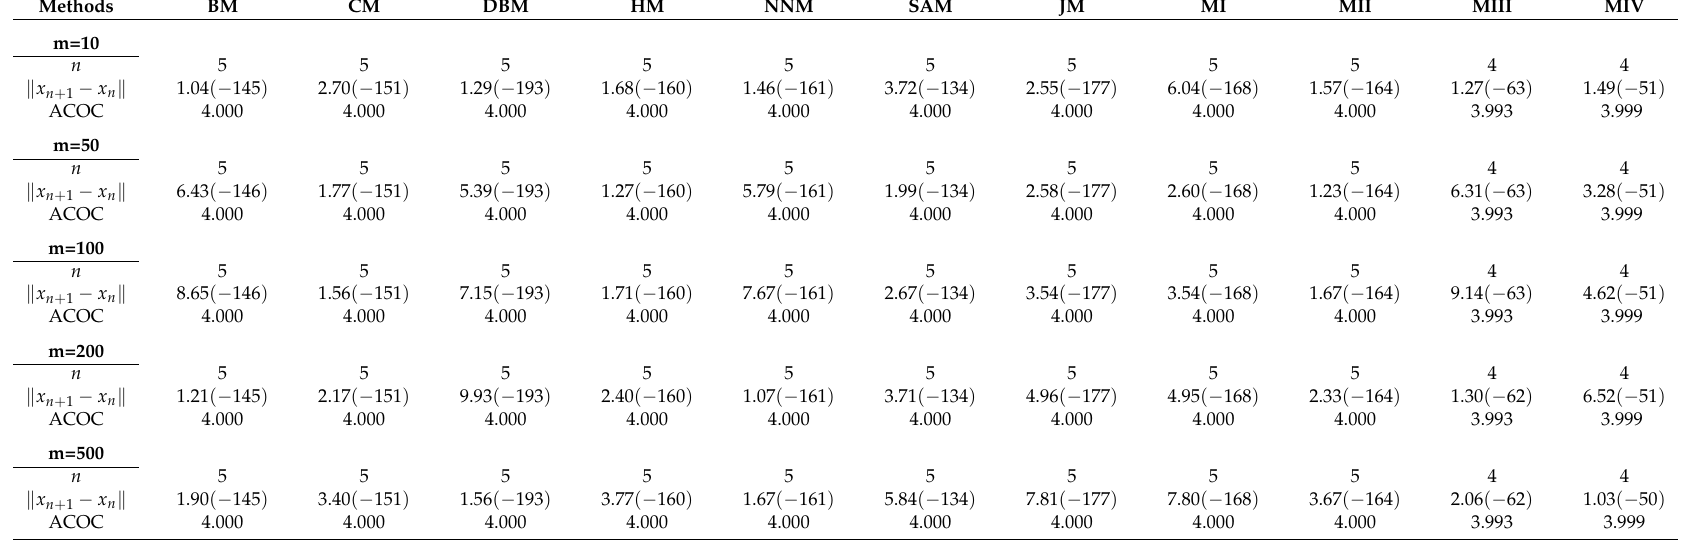
Table 6. Comparison of performance of methods for Problem